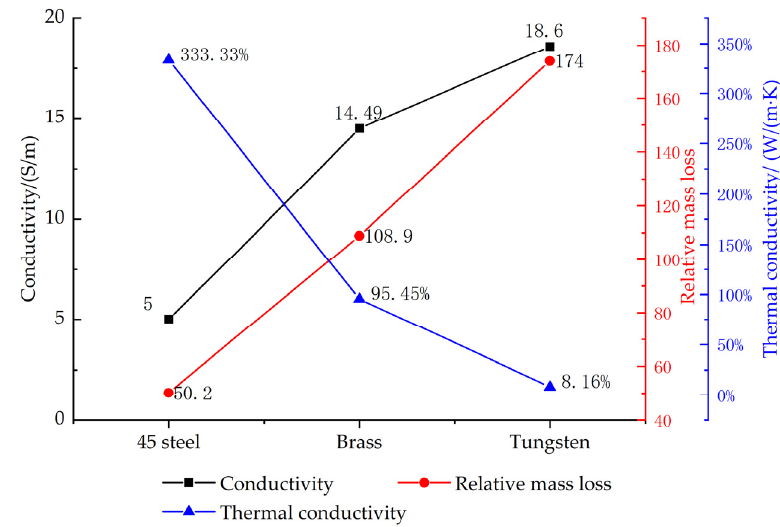
Figure 7. Relative mass loss of three electrodes.